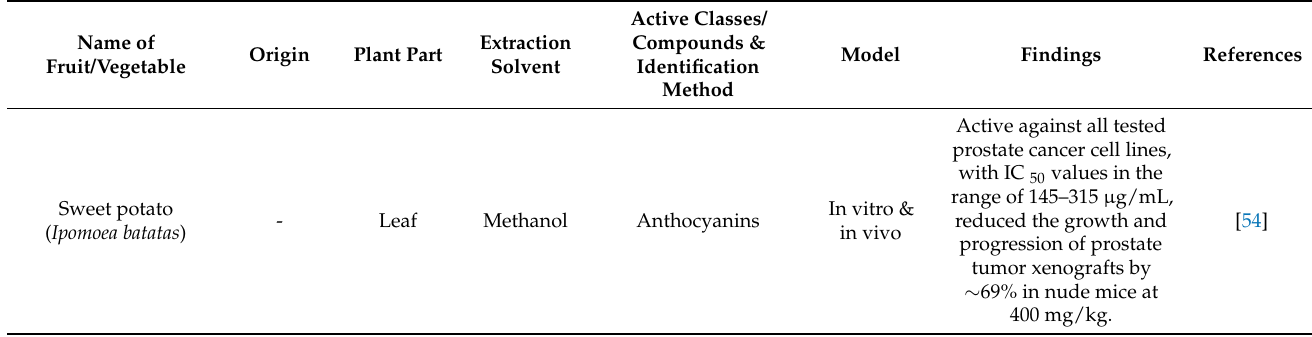
Table 2. Dietary polyphenols, from various fruits and vegetable extracts, against prostate cancer cell